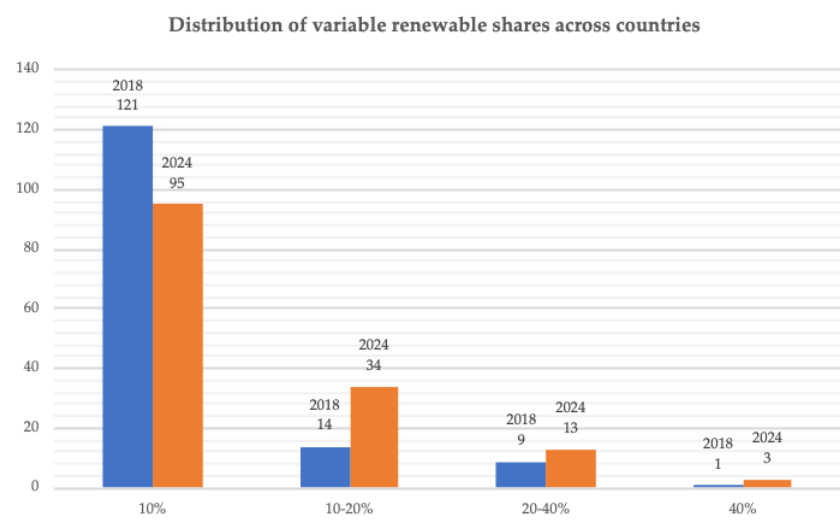
Figure 17. Distribution of variable renewable shares across countries (Source: IEA).